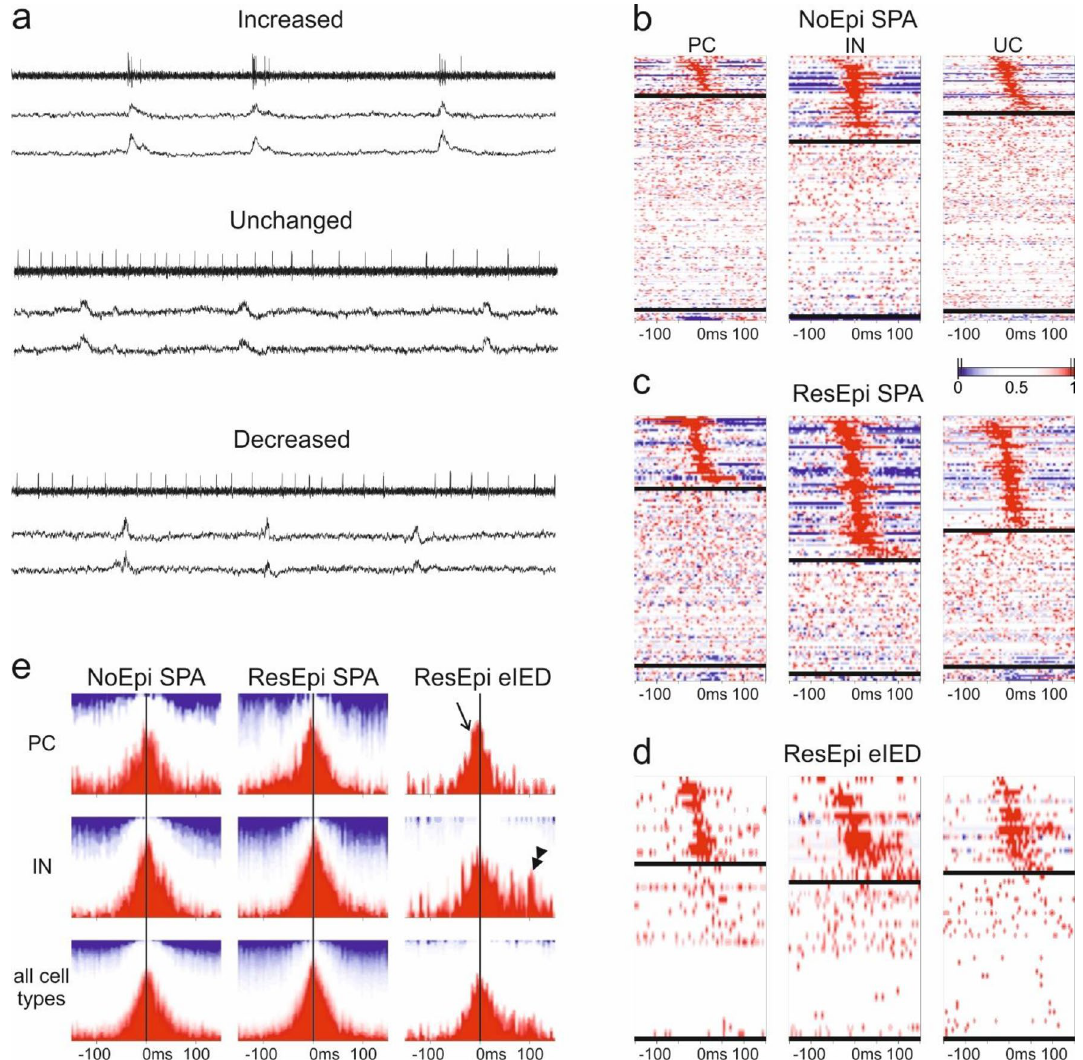
Figure 3. Firing rate change during SPA and eIED. ( a ) Examples for neurons with increased, unchanged and decreased firing rate during SPA. Upper traces show the activity of the neuron, lower two traces show the SPA (filters as in Fig. 2). Firing change quantiles of all neurons around the LFPg peak (time 0) of NoEpi SPA ( b ), ResEpi SPA ( c ) and ResEpi eIED ( d ). The three columns reflect principal cells (PC), interneurons (IN) and unclassified cells (UC), respectively. Each row illustrates one cell-SPA/eIED relation. Red shows increase, blue marks decrease in firing. Vertical black lines on the scale bar depict significant intervals. Horizontal black lines separate neurons with increased (upper part), unchanged (middle part) and decreased (lower part) firing. Higher proportions of PCs and INs elevate their firing rate during ResEpi than NoEpi SPA. Increased cells are sorted based on the timing of their maximal firing relative to the SPA/eIED. Note, that all cell types can increase their discharge rate at the beginning and at the end of the events. ( e ) Summary of firing change quantiles of all increased cells around the LFPg peak of NoEpi SPA (left), ResEpi SPA (middle) and ResEpi eIED (right). The peak firing of PCs during eIEDs precedes the LFPg maximum of the events (open arrow). INs (second row) show a symmetric build-up and decline during SPAs (both NoEpi and ResEpi), while displaying elevated firing long after the peak of eIEDs (double arrowhead). Considering the summarized activity of all increased cells of all cell types (third row), SPAs are symmetric, eIEDs are asymmetric